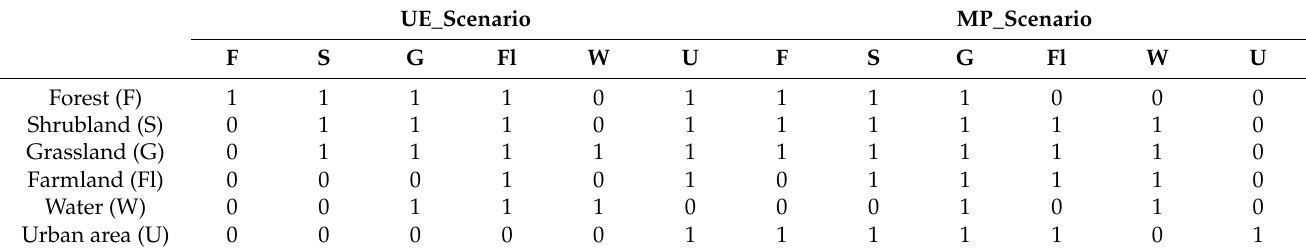
Table A1. The cost matrix in FLUS model simulation.